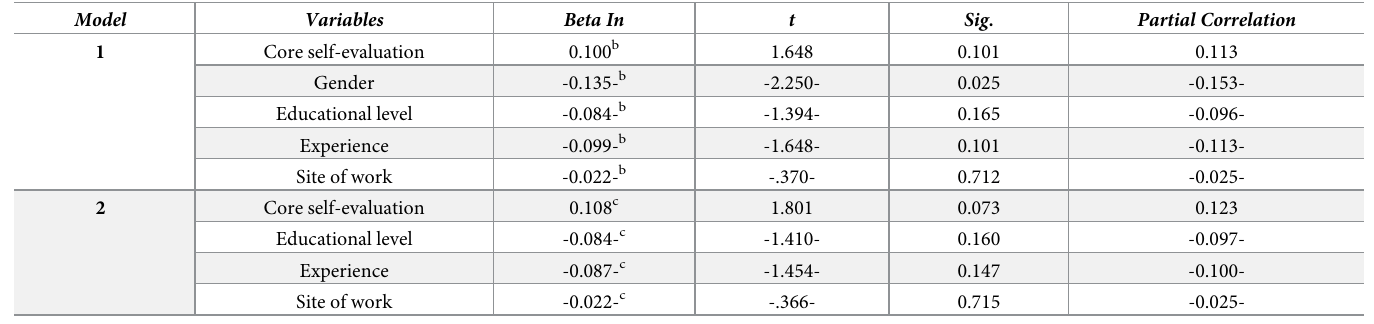
Table 6. Results of the excluded variables according to the multiple linear regression analysis for job security.